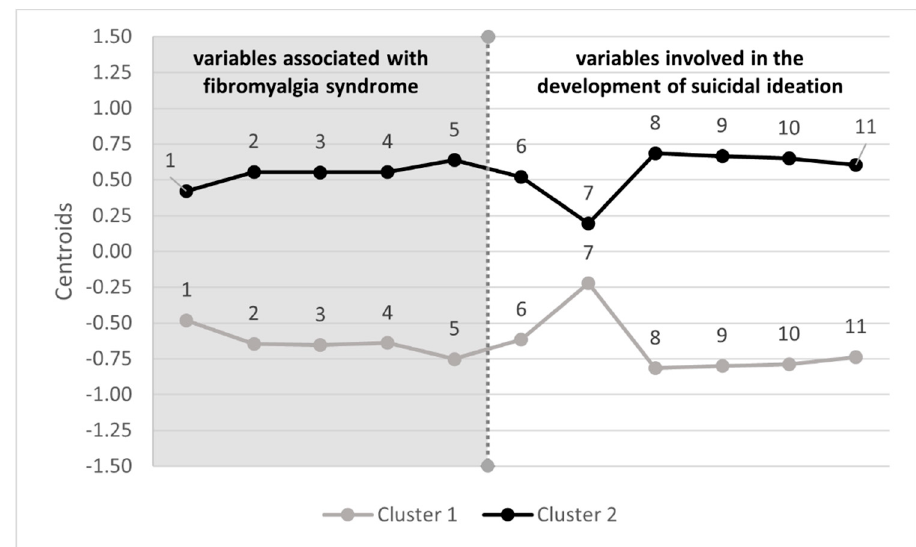
Figure 2. Profiles of suicidal ideation in patients with fibromyalgia. Note: On the left side of the dividing line are the variables specifically associated with fibromyalgia syndrome. On the right side are the variables essentially involved in the development of suicidal ideation; 1 = Physical function difficulty, 2 = Overall FM impact, 3 = Intensity of associated symptoms, 4 = Physical pain, 5 = Severity depressive symptomatology, 6 = Perceived burdensomeness, 7 = Thwarted belongingness, 8 = Defeat, 9 = Entrapment, 10 = Psychological pain, 11 = Hopelessness.